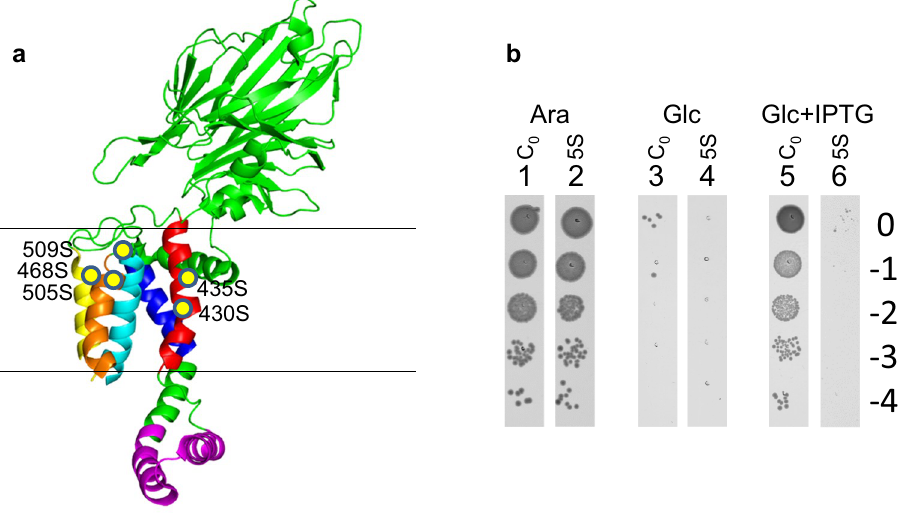
Figure 1. Construction and activity of a quintuple mutant YidC-5S. ( a ) Structure and topology of YidC-5S (PDB 3WVF). The locations of the 5 serine mutations are highlighted with yellow dots and are all located in the upper part of the hydrophobic slide of YidC; TM3 is coloured in red, TM4 in yellow and TM5 in gold. ( b ) Colony growth of MK6 cells with plasmids encoding the cysteine-less YidC 0 (lane 1, 3, 5) or the YidC-5S mutant (lane 2, 4, 6). The cells were either grown on plates containing 0.2% arabinose that allow expression of the chromosomal yidC (lanes 1, 2), or on plates containing 0.4% glucose that repress the chromosomal yidC (lanes 3, 4), or on plates with glucose and 1 mM IPTG that induce the plasmid-encoded yidC (lanes 5, 6). Serial dilutions (tenfold, indicated on right margin) of the respective cultures were applied onto the agar plates and incubated at 37 °C